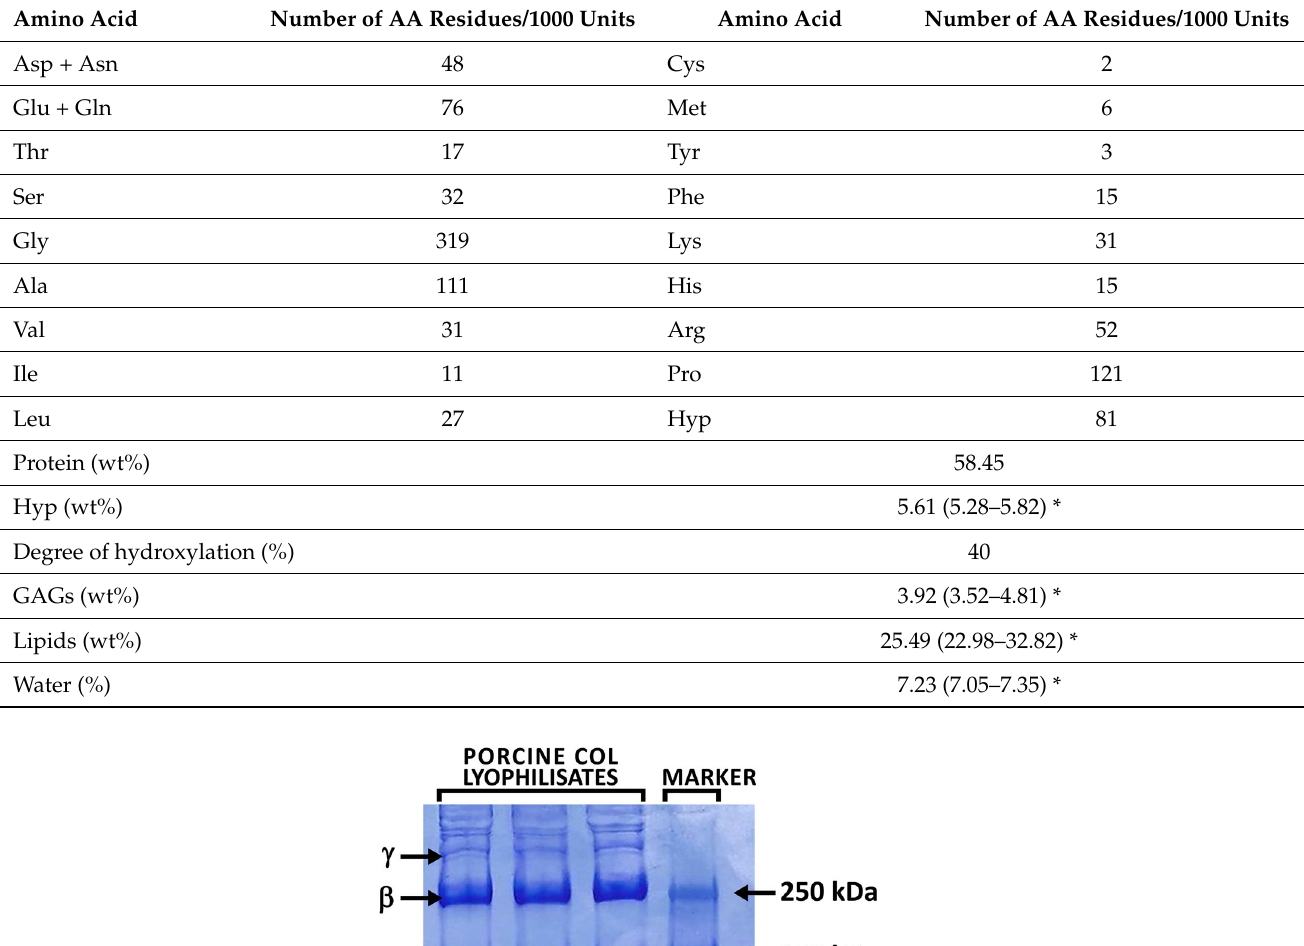
Table 1. Composition of COL lyophilizate isolated from porcine skin. “*” marked lower and upper quartile.